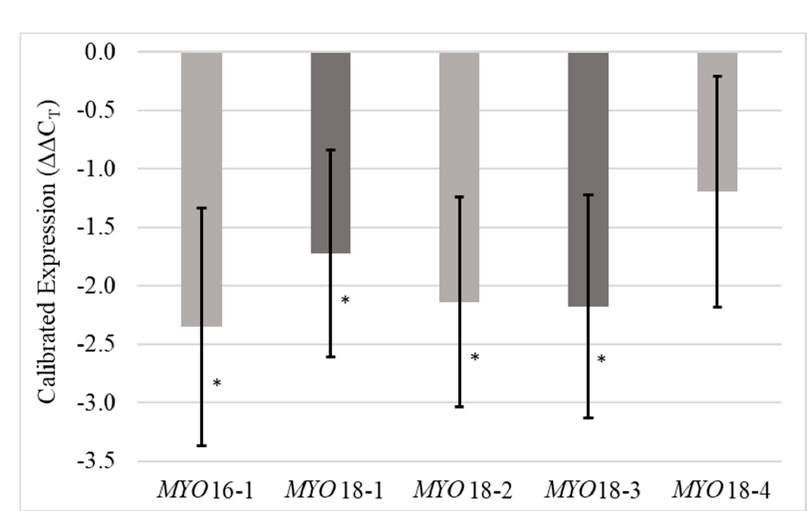
Figure 1. Transgenic mRNA expression normalized to the expression of the house-keeping gene MEP and calibrated to the expression of these genes within the wild type (Viking). Error bars represent standard errors. Stars represent significance at the 0.05 level.